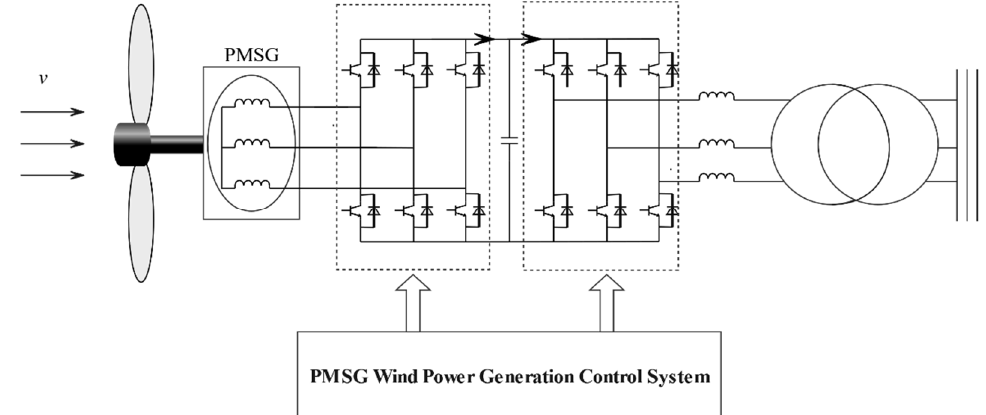
Figure 1. The schematic diagram of direct-drive wind energy conversion system.